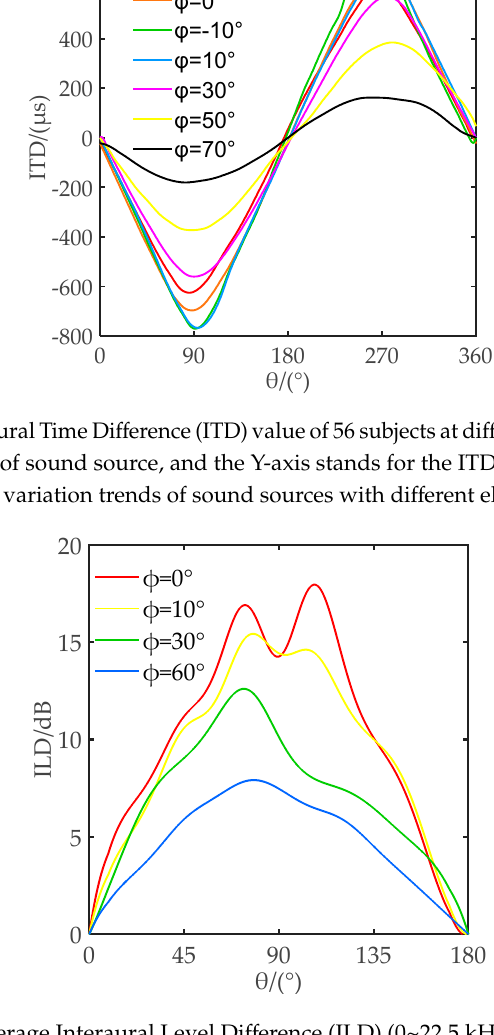
Figure 2. Broadband average Interaural Level Difference (ILD) (0 ~ 22.5 kHz) at different directions in audible band of 56 subjects. X-axis and Y-axis denote the azimuth and ILD value of sound source, respectively. Curves in different color represent the ILD variation trend of sound sources with different elevations.